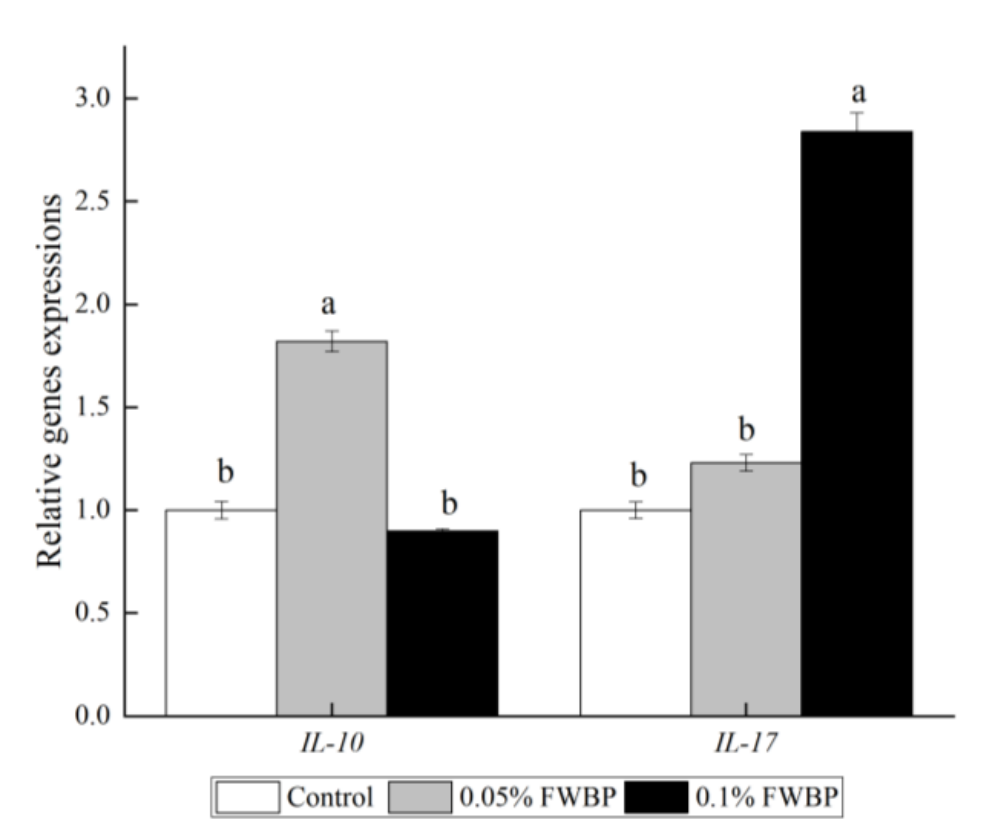
Figure 5. Gut inflammation-related gene expression in zebrafish fed with FWBP. FWBP: Fermented wheat bran polysaccharides. IL-10: Interleukin 10; IL-17: Interleukin 17. Different lowercase super- script letters denote statistically significant differences among different groups ( p < 0.05).